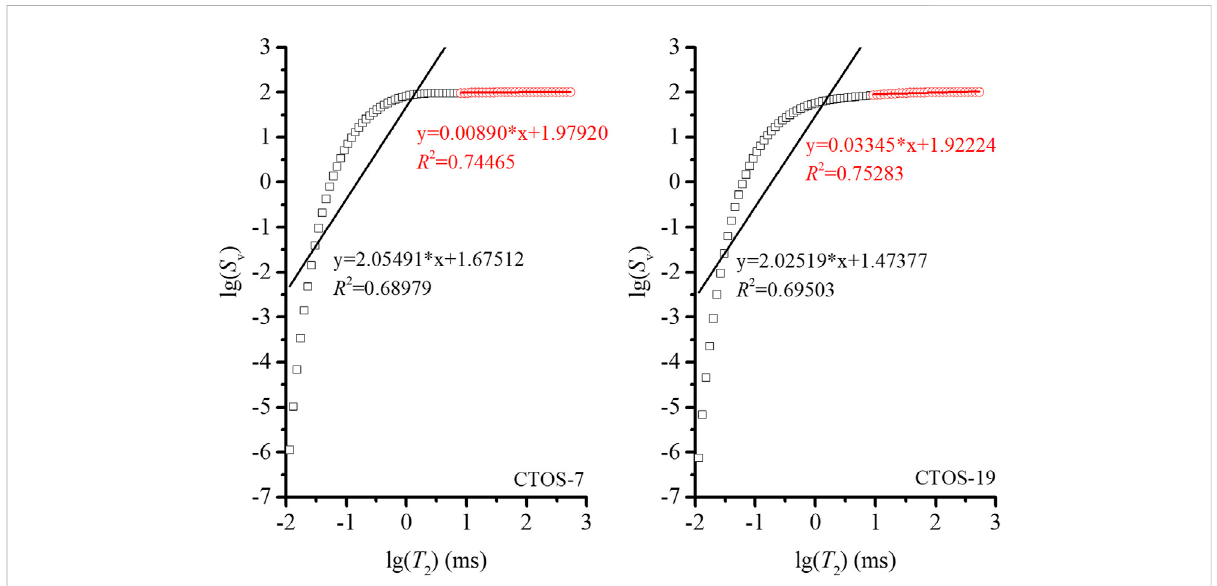
FIGURE 5 The primary pore classi fi cation of CTOS-7 and CTOS-19 samples.